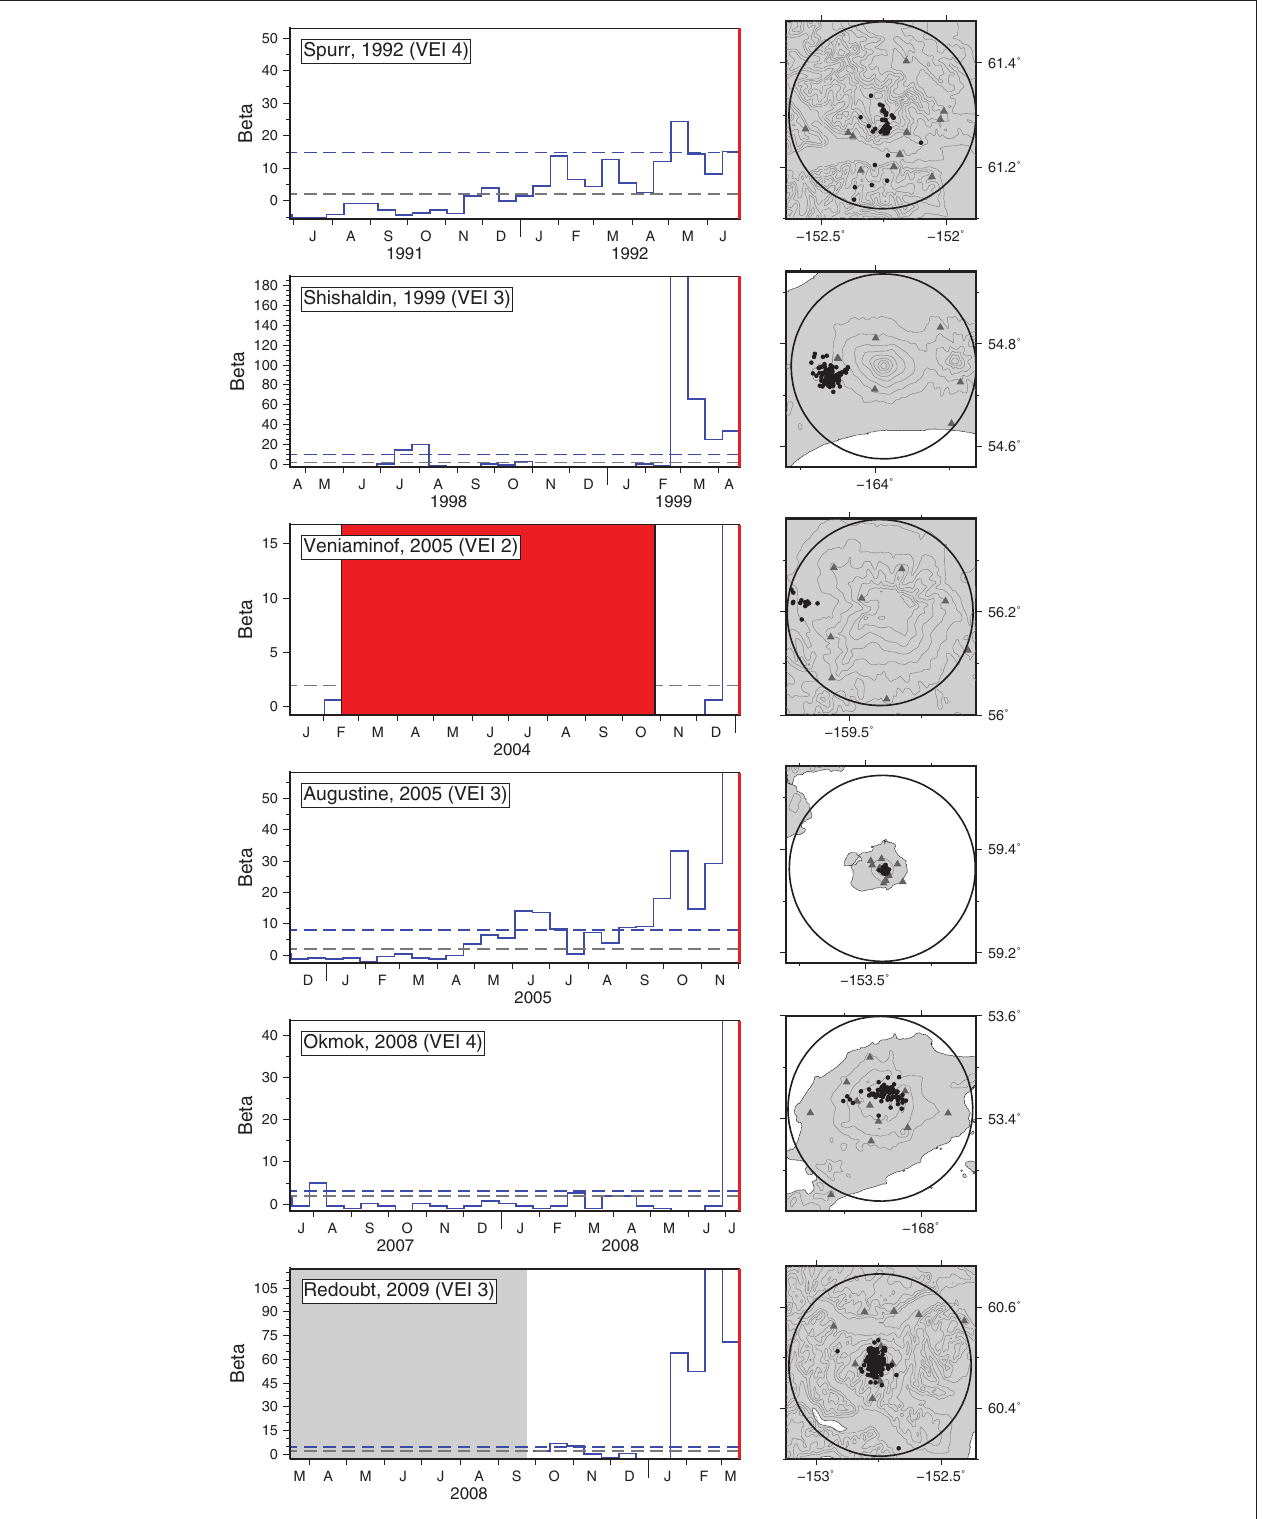
FIGURE 3 | Results of the β -statistic test for T a = 14 days and R = 20km, which corresponds to the maximum values for these parameters for which all 6 anomalies are identified. X-axes show the year prior to the eruption, similar to Figure 1B . Y-axes are scaled by the maximum anomaly seen over the entire time period analyzed (see Figure 7 ). Maps show events within T a = 14 days of eruption. See Figure 2 and text for additional details.